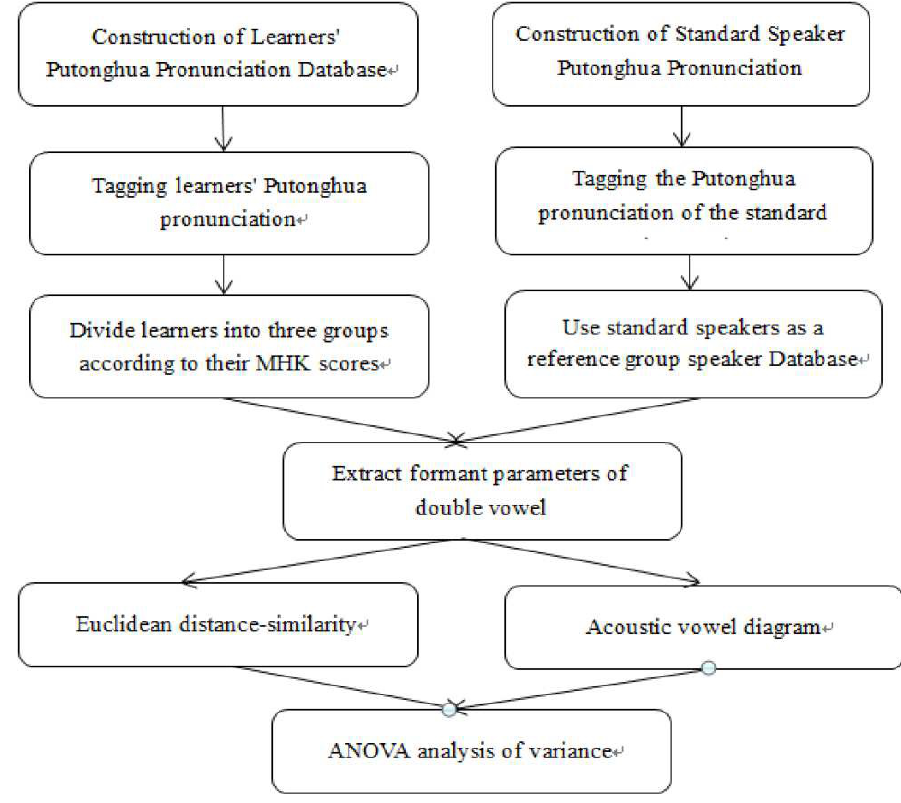
Fig. 1 Flow chart of the experiment.